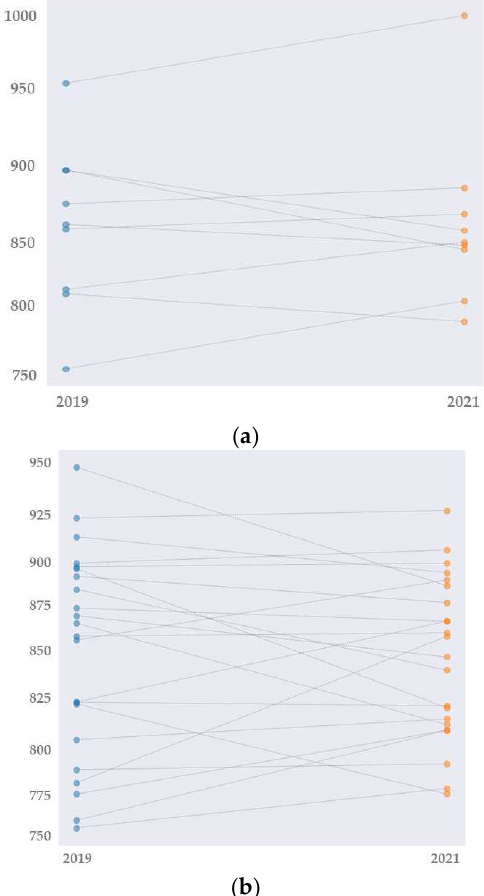
Figure 1. Time-ranking points change from 2019 to 2021 in COVID-athletes ( a ) and non-COVID athletes ( b ). Figure Legend: blue dots: time-ranking points of 2019, orange dots: time-ranking points of 2021.